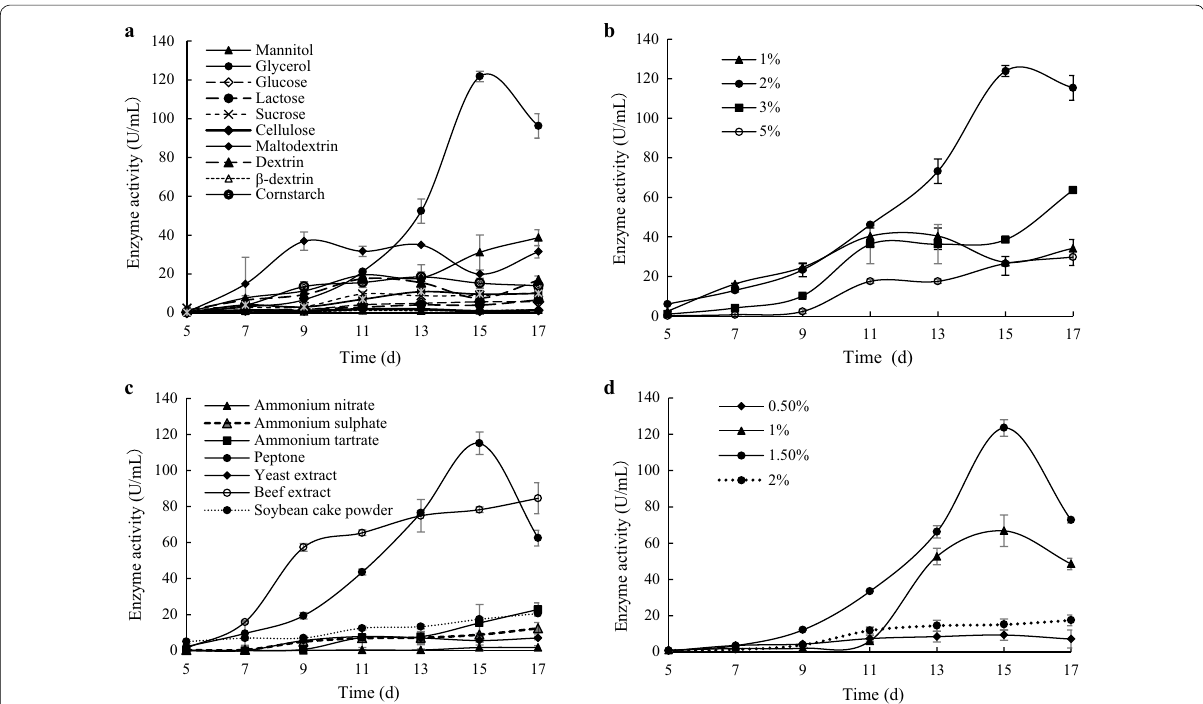
Fig. 1 Laccase production by C. unicolor CGMCC 5.1011. a Effect of carbon sources on laccase production. b Effect of glycerol concentration on laccase production. c Effect of nitrogen sources on laccase production. d Effect of peptone concentration on laccase production